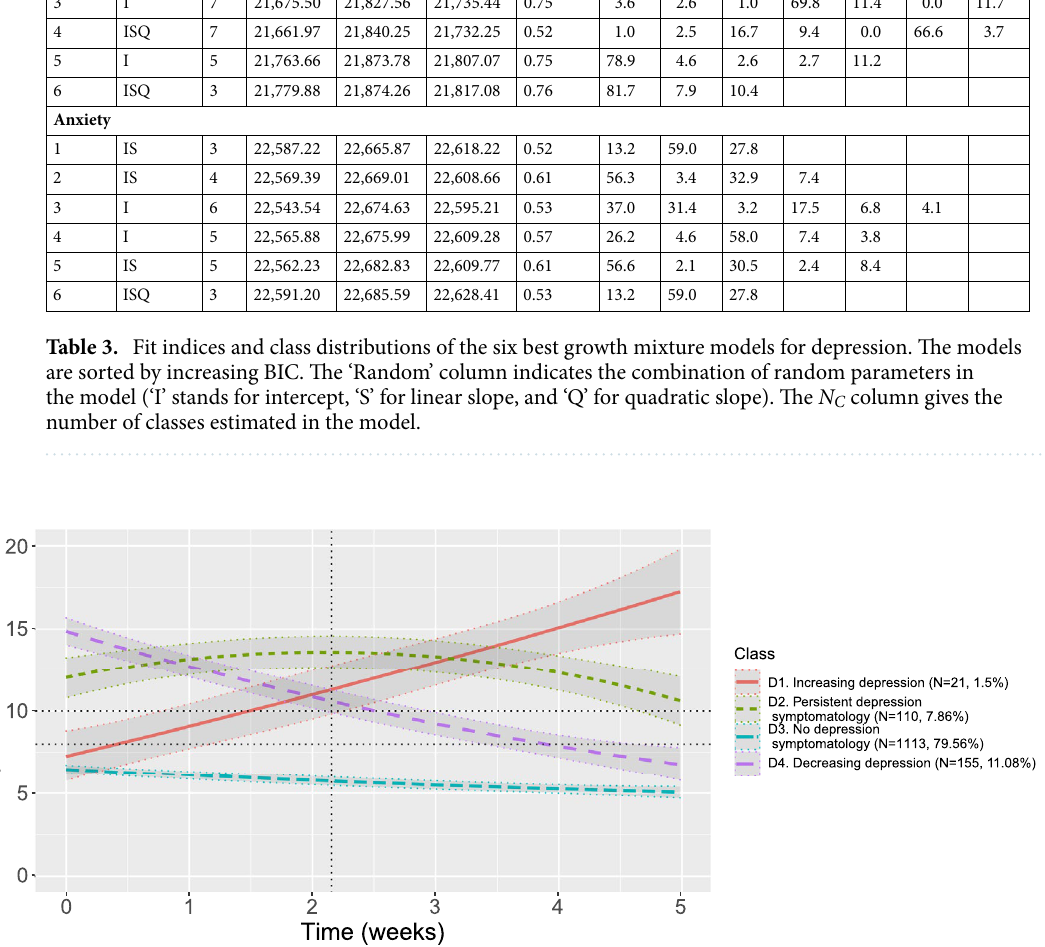
Figure 1. Predicted trajectories from selected growth mixture model of depression. Dashed horizontal lines represent symptomatic thresholds for depression (i.e., 8 and 10). The dashed vertical line depicts the moment unlockdown